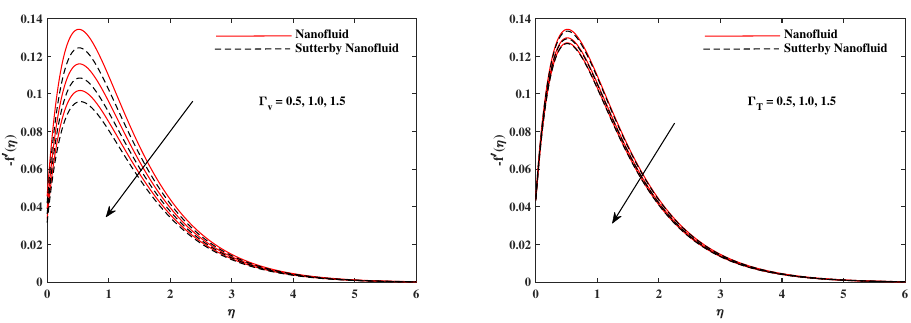
Figure 5. f (cid:48) ( η ) fluctuate in x-direction with Γ v and Γ T